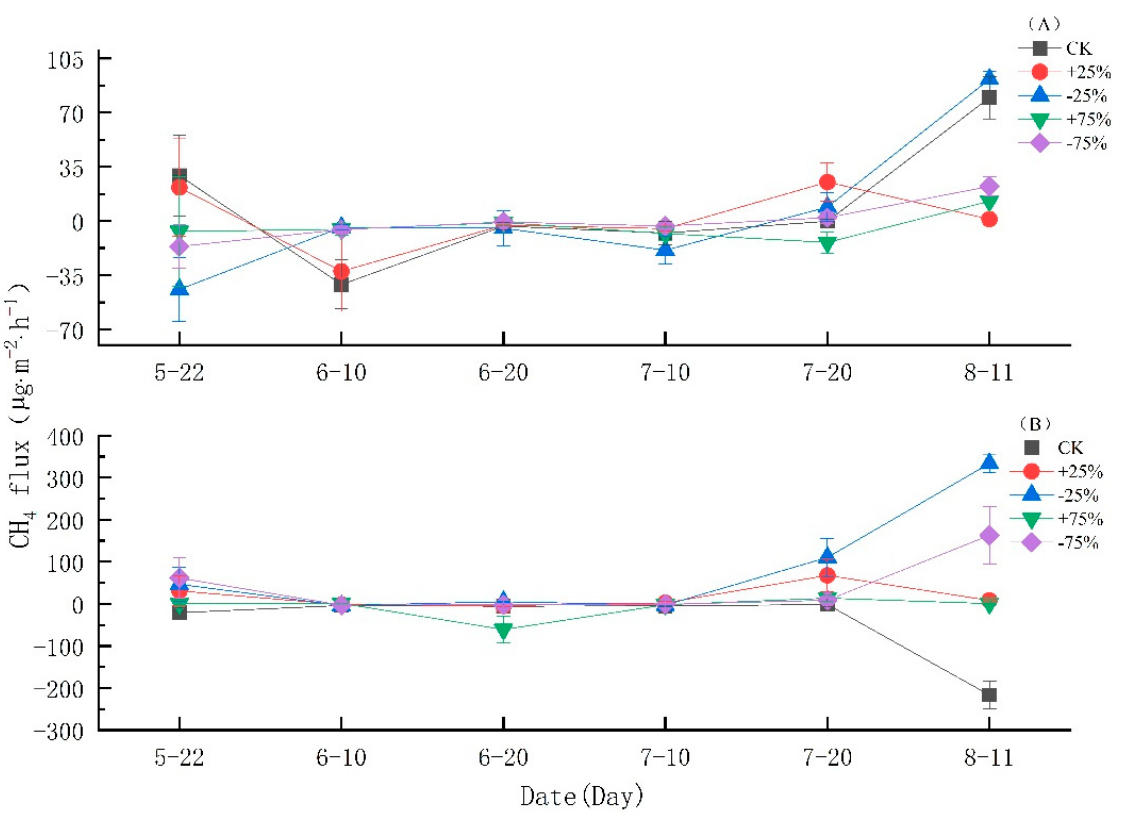
Figure 3. CH 4 emission characteristics during the growing season under different rainfall treatments. Change diagram of the CH 4 emission flux at 11:00 a.m. ( A ). Change diagram of the CH 4 emission flux at 3:00 p.m. ( B ).